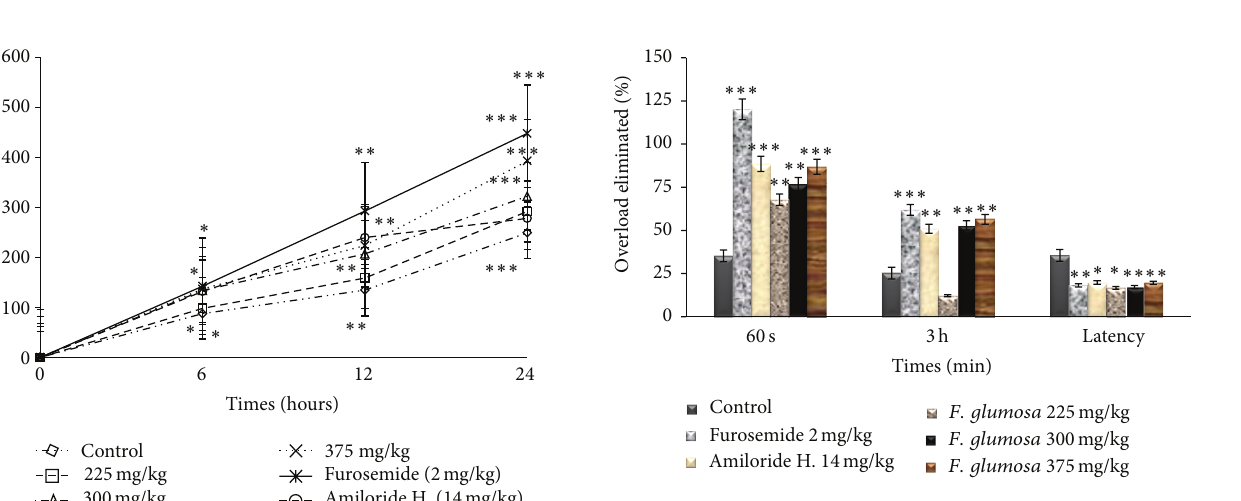
Figure2:Effectsoftheaqueousextractof F.glumosa ontheoverload eliminated. Values are means ± SEM, 𝑛 = 5 , ∗ < 0.05 , ∗∗ < 0.01 , and ∗ ∗ ∗ < 0.001 , significant difference compared to the